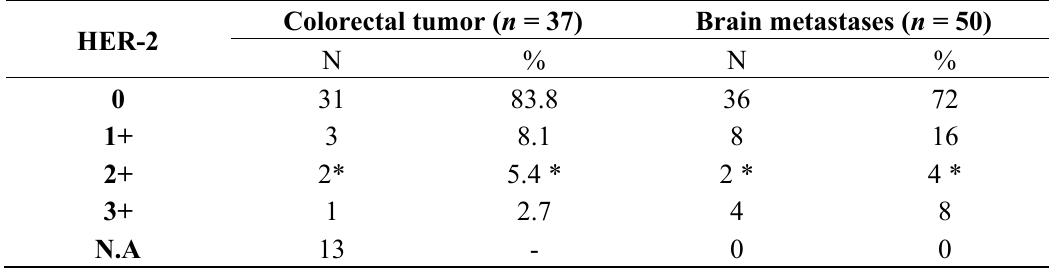
Table 4. Colorectal ( n = 37) and brain metastases ( n = 50) HER-2 expression and immunohistochemical score.